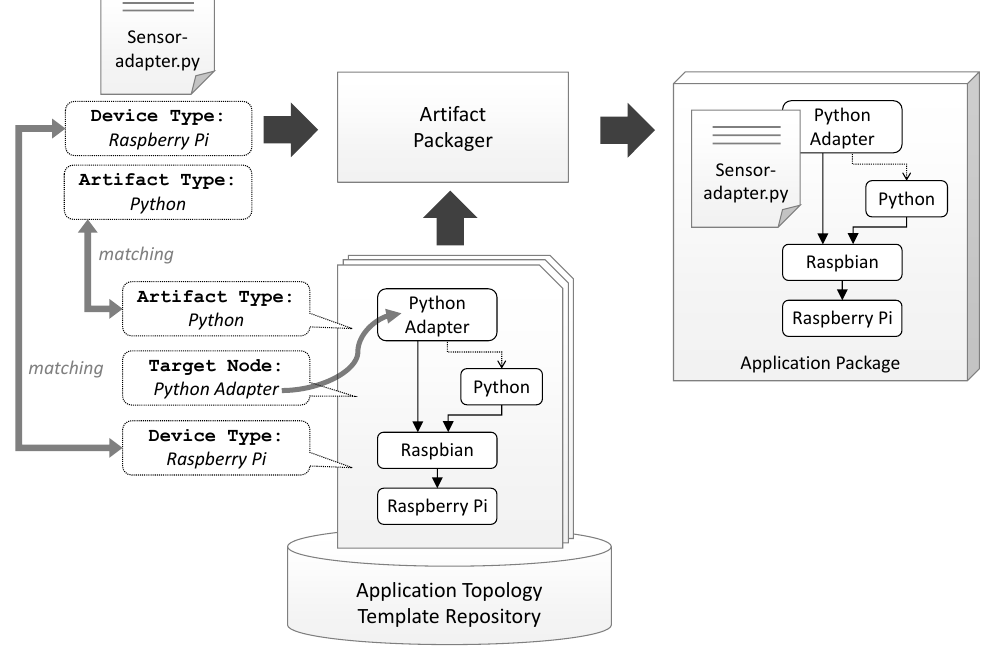
Figure 4. Artifact Packager with the Application Topology Template Repository for inserting software device adapters into suitable application topology